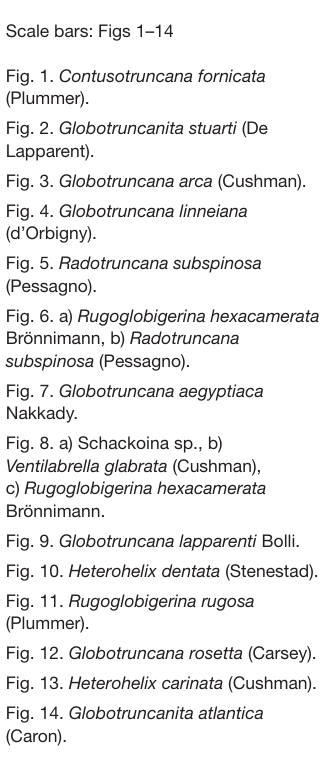
Fig. 1. Contusotruncana fornicata (Plummer). Fig. 2. Globotruncanita stuarti (De Lapparent). Fig. 3. Globotruncana arca (Cushman). Fig. 4. Globotruncana linneiana (d’Orbigny). Fig. 5. Radotruncana subspinosa (Pessagno). Fig. 6. a) Rugoglobigerina hexacamerata Brönnimann, b) Radotruncana subspinosa (Pessagno). Fig. 7. Globotruncana aegyptiaca Nakkady. Fig. 8. a) Schackoina sp., b) Ventilabrella glabrata (Cushman), c) Rugoglobigerina hexacamerata Brönnimann. Fig. 9. Globotruncana lapparenti Bolli. Fig. 10. Heterohelix dentata (Stenestad). Fig. 11. Rugoglobigerina rugosa (Plummer). Fig. 12. Globotruncana rosetta (Carsey). Fig. 13. Heterohelix carinata (Cushman). Fig. 14. Globotruncanita atlantica